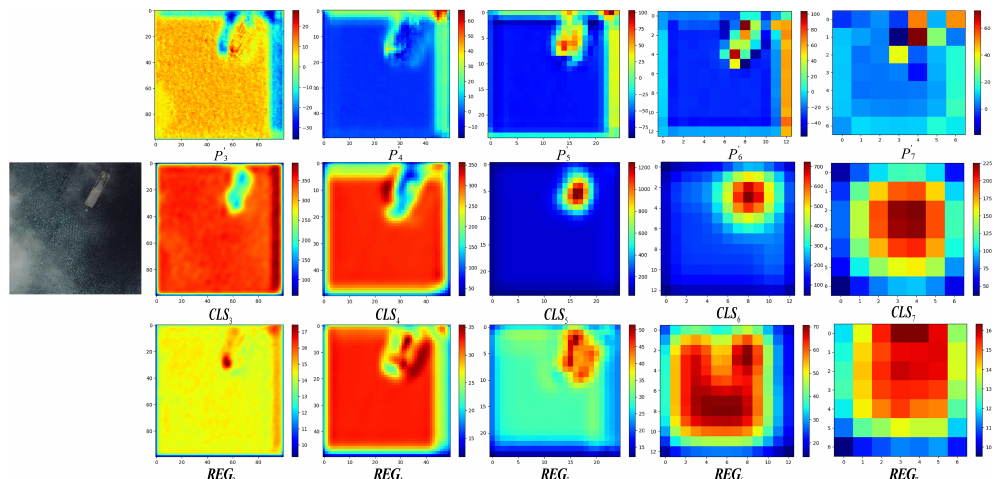
( i = 3,4,5,6,7 ) used for i